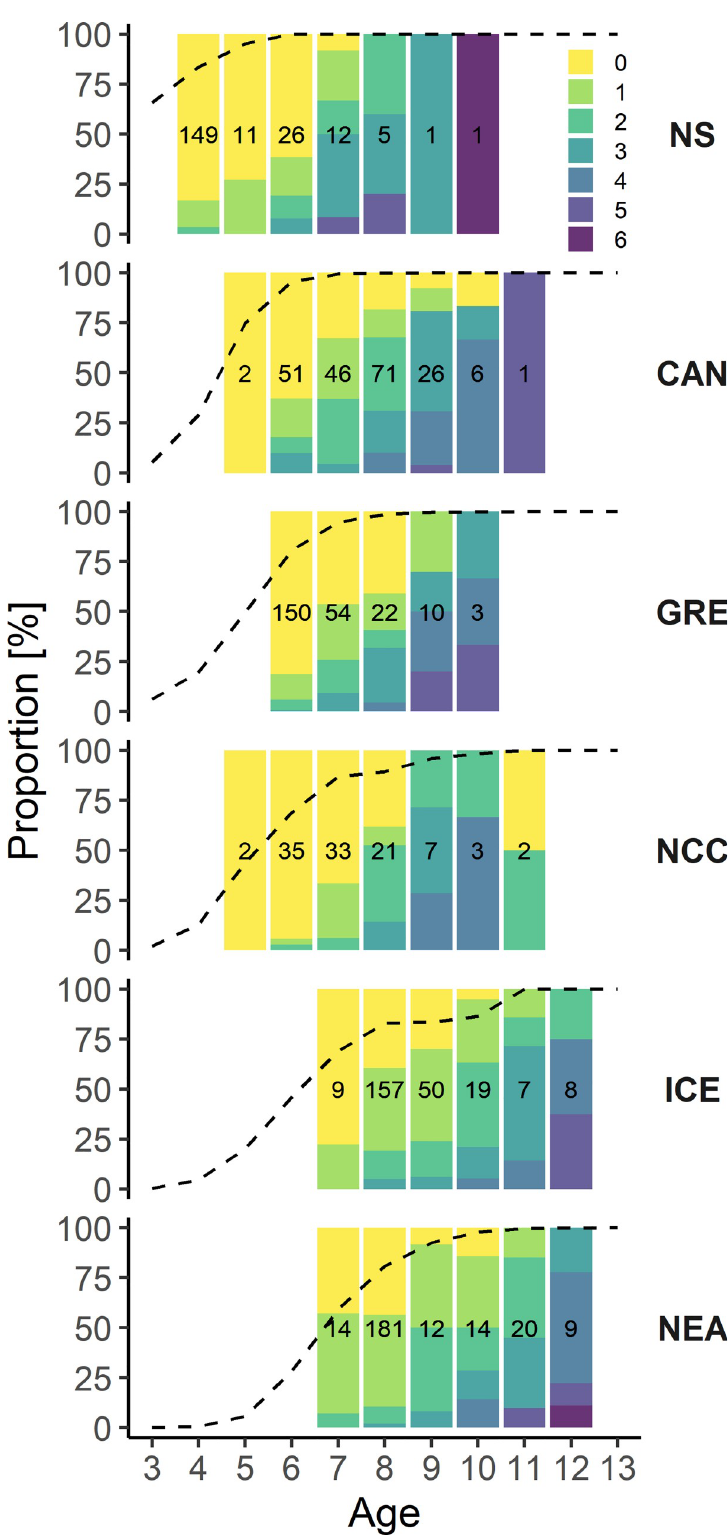
Fig 4. Proportions of otoliths and spawning zones identified per age class and population. Color scale refers to the number of spawning zones counted. Column numbers indicate the number of otoliths available from each age class for